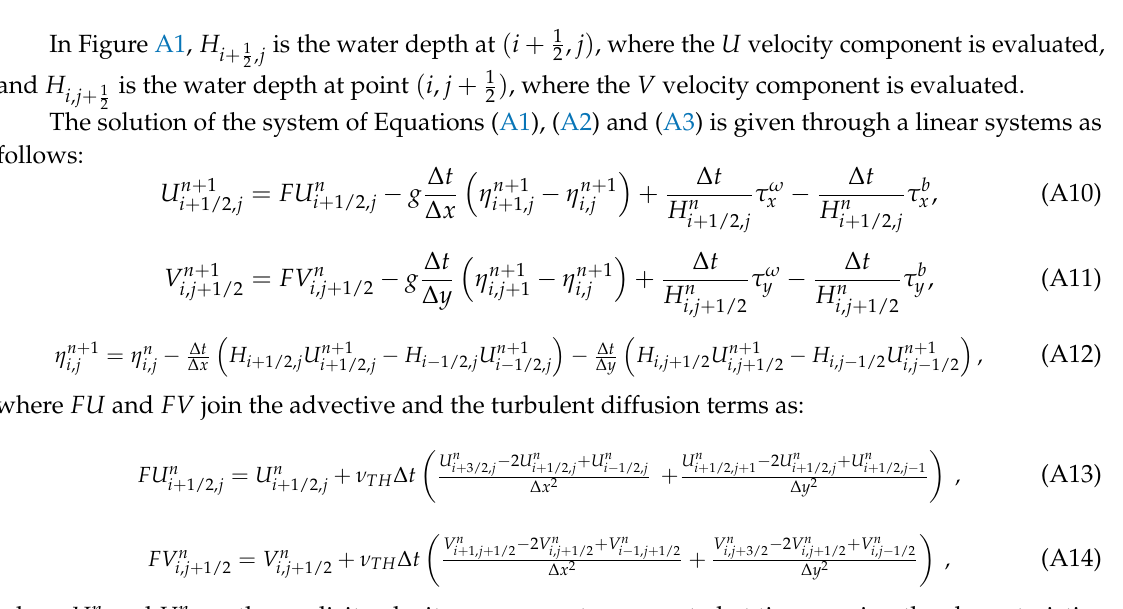
Figure A2. Discretization Cell (top